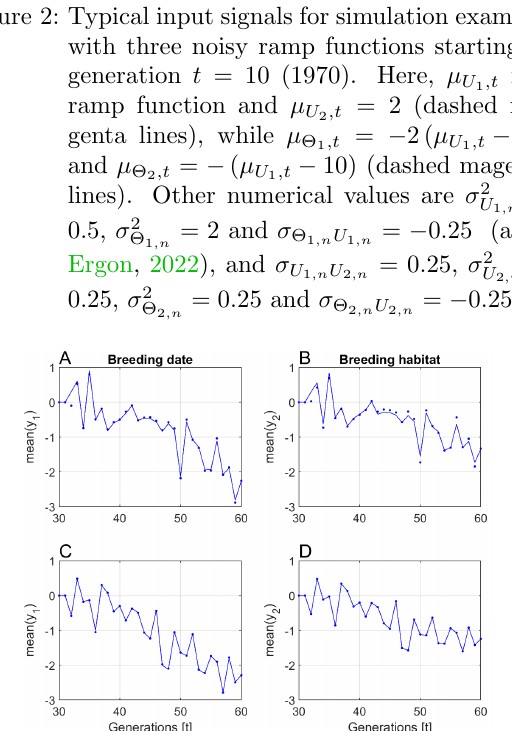
Figure 3: True outputs (solid lines) and outputs from tuning model (dots), for two choices of tun- ing model, and with use of input-output data from the last 30 generations in Figure 2. The responses in panels A and B are obtained with the true reference environments u 1 , ref = u 1 , 1 = 10 and u 2 , ref = u 2 , 1 = 2, which leads to convergence problems. The responses in panels C and D are obtained with assumed reference environments u 1 , ref = u 1 , 31 and u 2 , ref = u 2 , 31 , which in most realizations gives good convergence, but prediction errors as discussed in Subsection 2.2. These errors can to some degree be corrected if the true values of u 1 , ref and u 2 , ref are